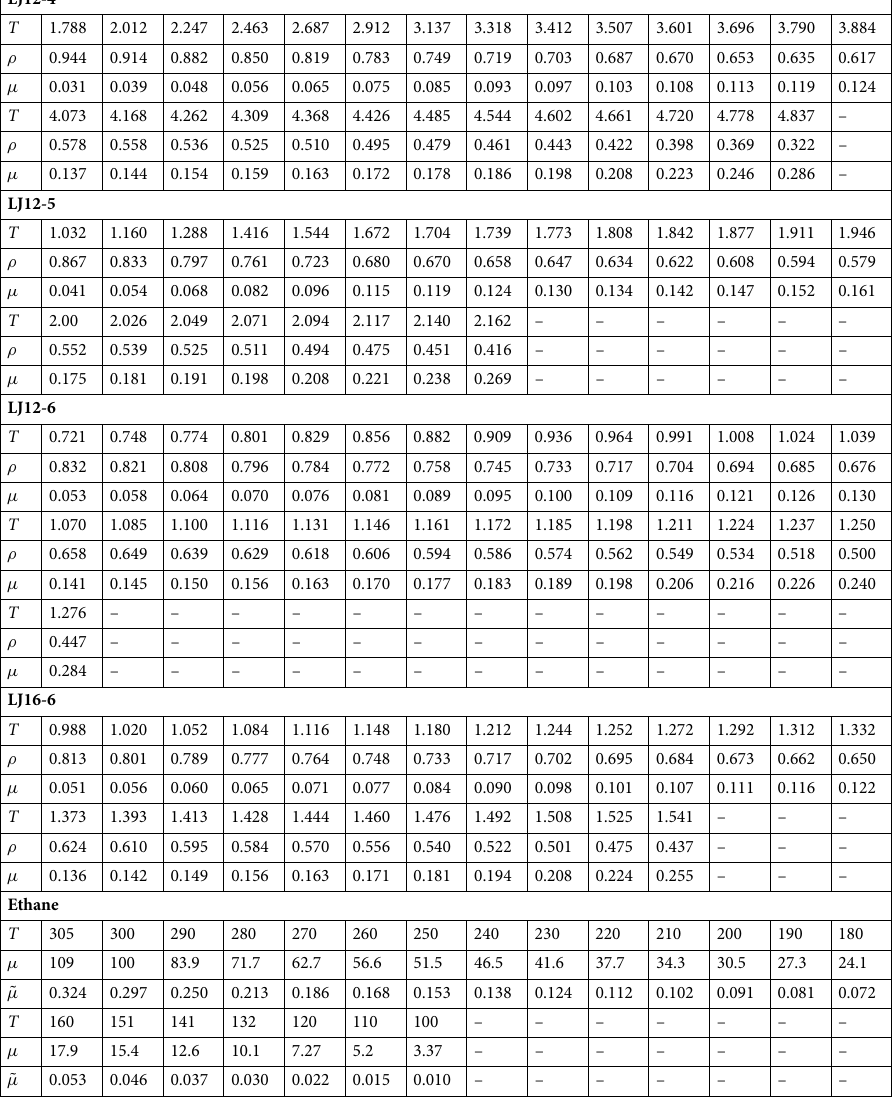
Table 2. Particle mobility calculated for studied generalised LJ systems (in normalised units) and for ethane 2 /(µ s · K ) ε M /σ 2 , where M = 30.07 g / mol is ethane molar (in K and nm and ˜ µ = µ (cid:31)